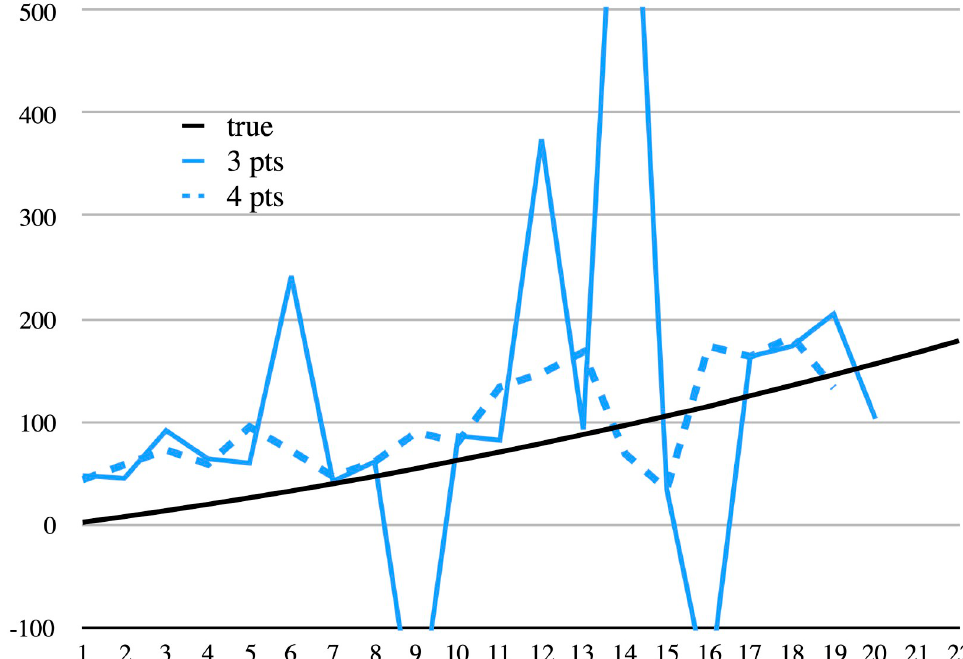
Fig 10. 1QS ( Community Rule ). Measured length compared to calculated lengths in cms. Calculated estimates are shown for three damage points (solid) and four (dashed). See legend at Fig 7.